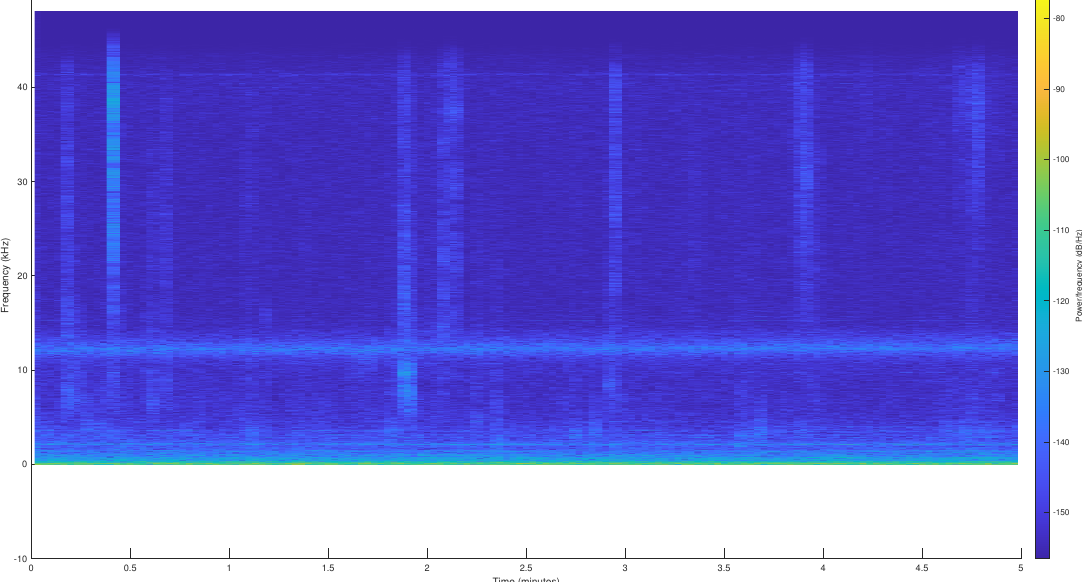
Figure 16. Power Spectrum or Spectrogram of an underwater acoustic signal by means of the Fast Fourier